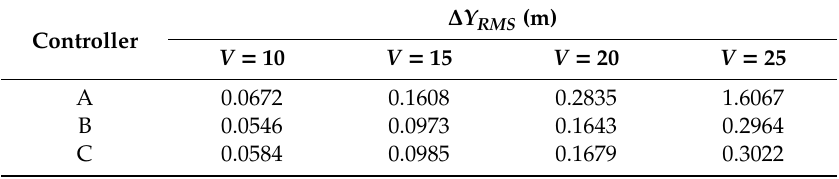
Table 5. Lateral deviations of 3 controllers at different vehicle velocities V (m/s).